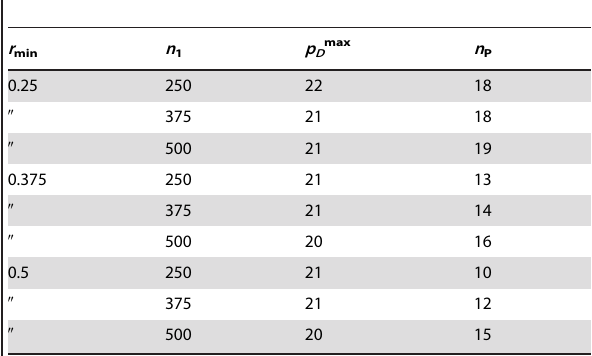
Table 3. The effects of the values of the nuisance parameters r min and n 1 on the number of chromosomes that show significant values for the test statistics p D max and n P at the nominal p , 0.05 level (without a Bonferroni correction).